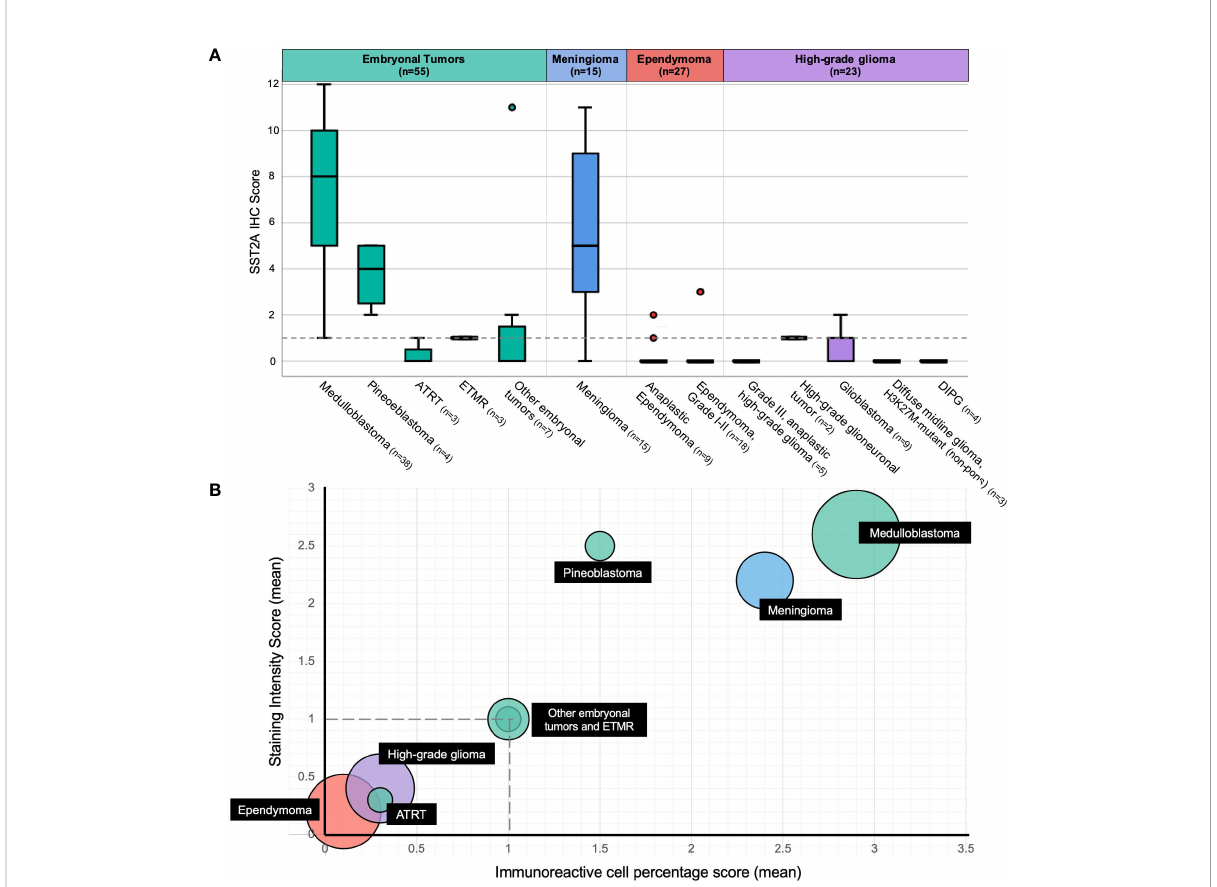
FIGURE 2 Membranous SST2A expression by histopathology. (A) Boxplot of total SST2A IHC score (y-axis) for pediatric CNS tumors of different histopathologic diagnoses (x-axis). The dashed gray line (corresponding to a total SST2A IHC score of 1) distinguishes between negative (0-1) and positive ( ≥ 2) SST2A IHC scores. (B) Bubble plot of mean SST2A IHC subscores (staining intensity score on y-axis, immunoreactivity score on x-axis) for different histopathologic diagnoses (indicated in black boxes), with circle size proportional to the number of patients analyzed within each respective histopathology group. The dashed horizontal and vertical gray lines (corresponding to staining intensity and immunoreactivity scores of 1, respectively) illustrate the subscore thresholds below which total SST2A IHC scores would be considered negative